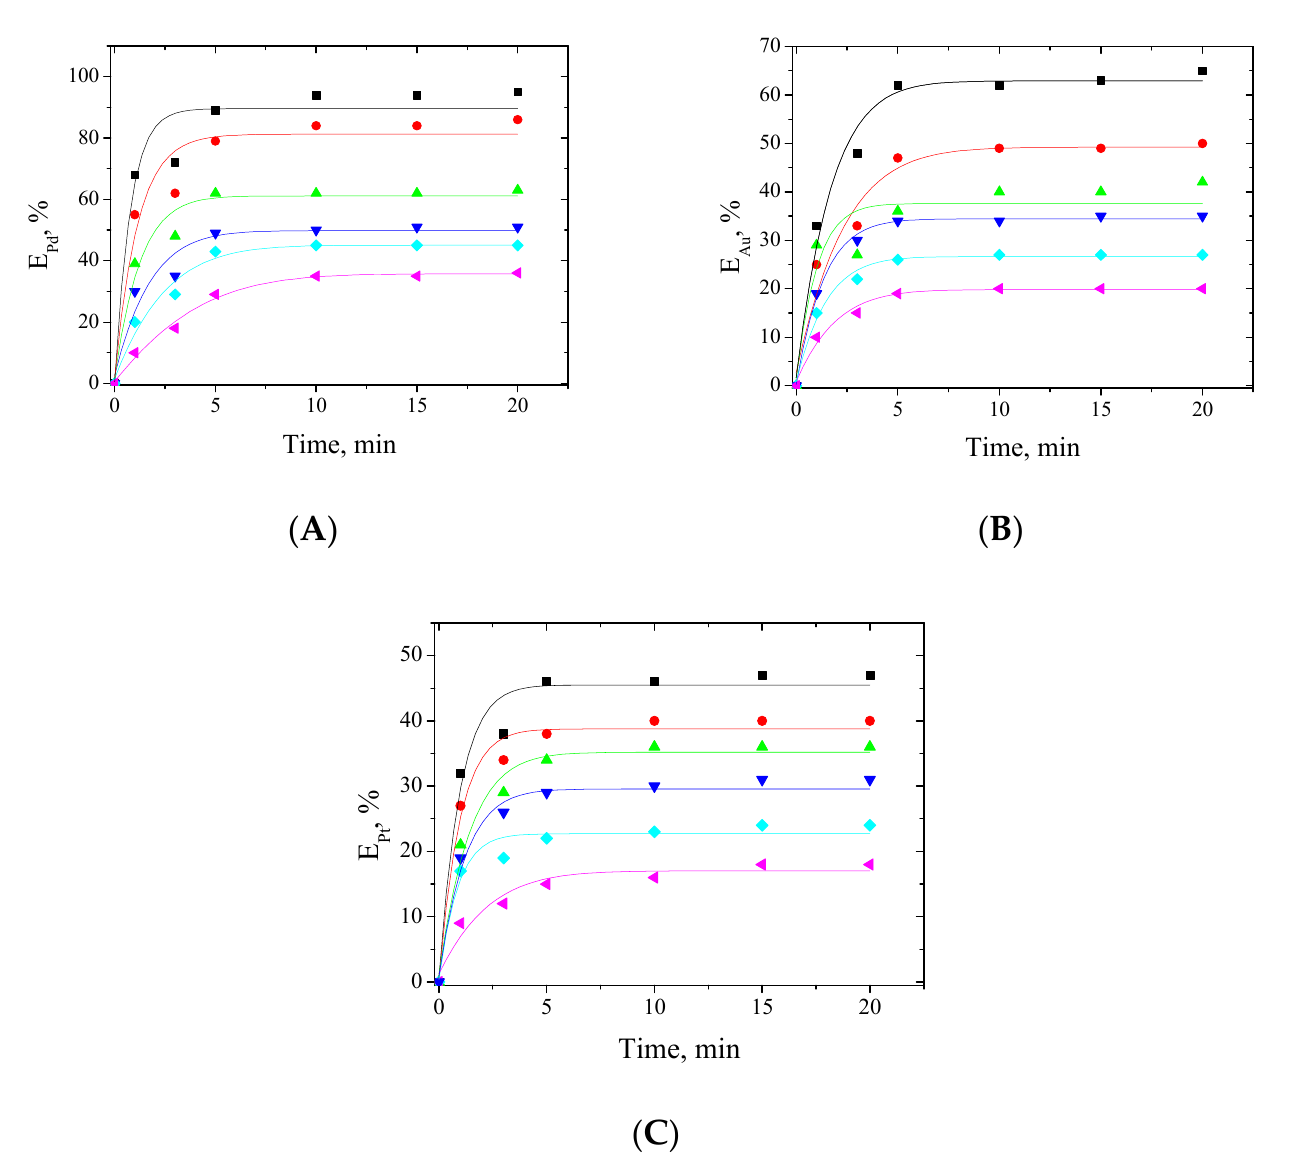
Figure 4. Effect of HCl concentration on extraction of Pd(II) ( A ), Au(III) ( B ), and Pt(IV) ( C ) with EDAB-acac in methylene